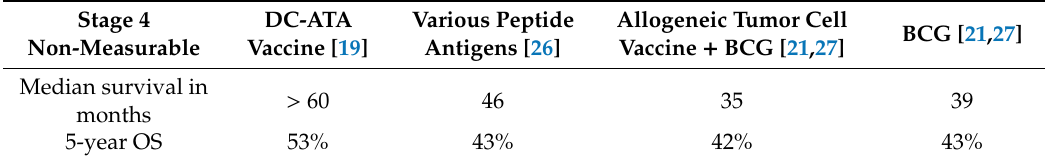
Table 2. Survival associated with immunotherapies for patients with prior stage 4 melanoma, but no measurable disease at the time of